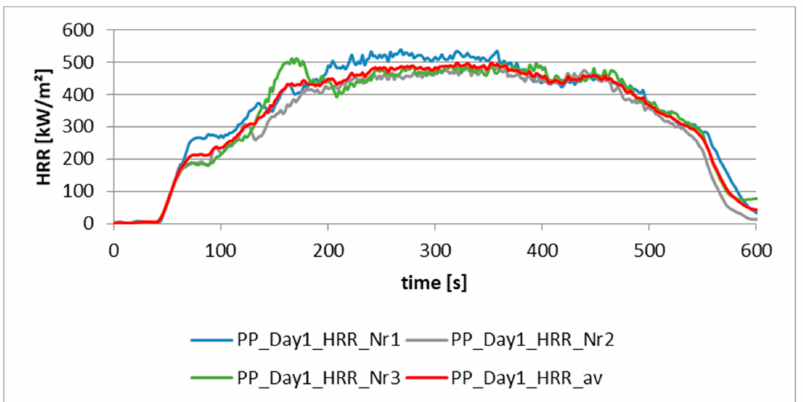
Figure 2. Heat release rate (HRR) of three samples of PP (granules were pressed, m = 50 g) on the first day after